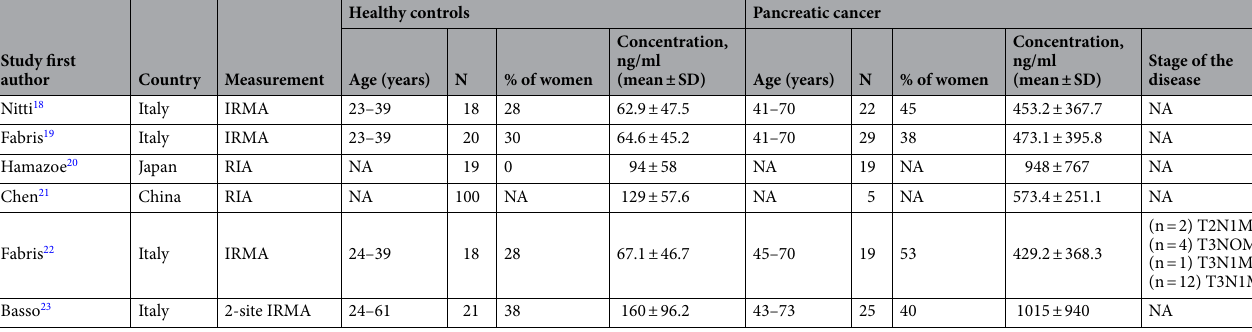
Table 1. Summary of case–control studies investigating levels of serum ferritin in pancreatic cancer patients. IRMA immunoradiometric assay, RIA radioimmunoassay, NA not